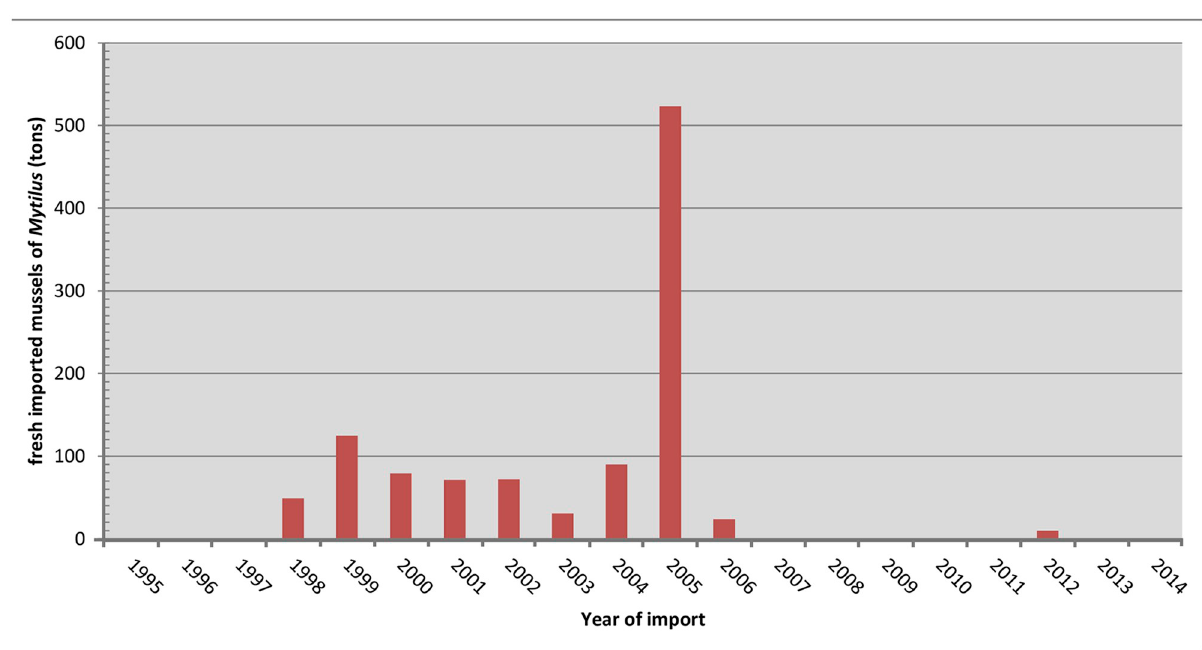
Fig 12. Imports of fresh Mytilus galloprovincialis mussels from Chile by Galicia. Source of data from the database Datacomex [91].